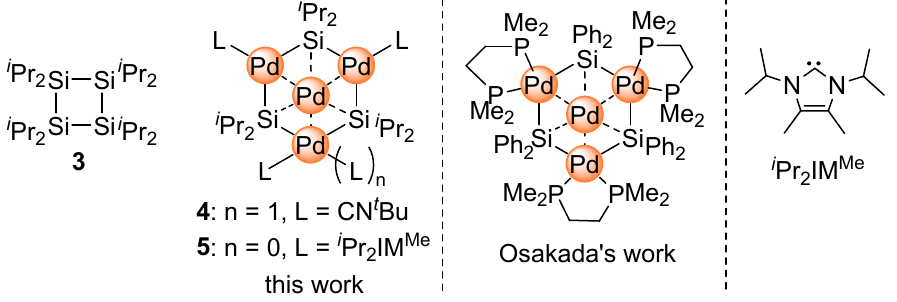
Chart 1. Structures of octaisopropylcyclotetrasilane 3 , palladium clusters having bridging silylene ligands, and N -heterocyclic carbene ligand ( i Pr 2 IM Me ).